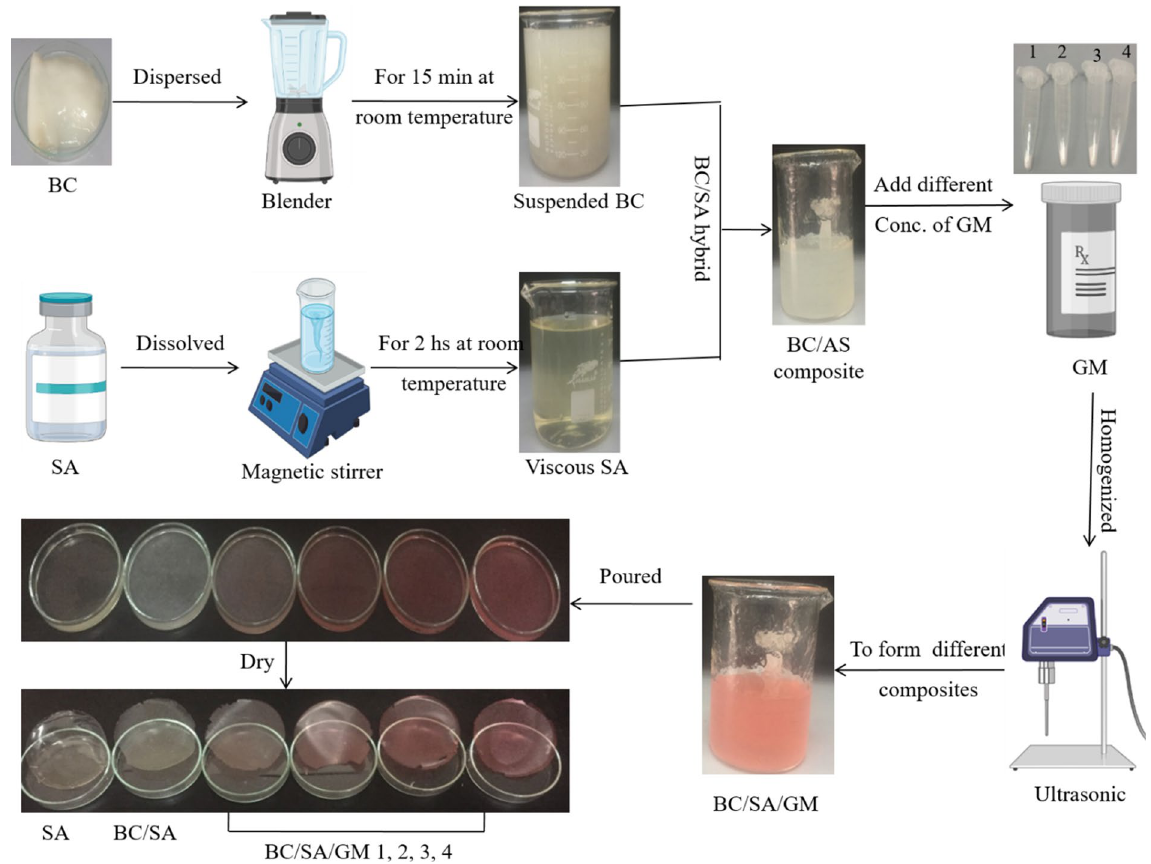
Figure 9. Schematic fabrication process of BC/SA composite